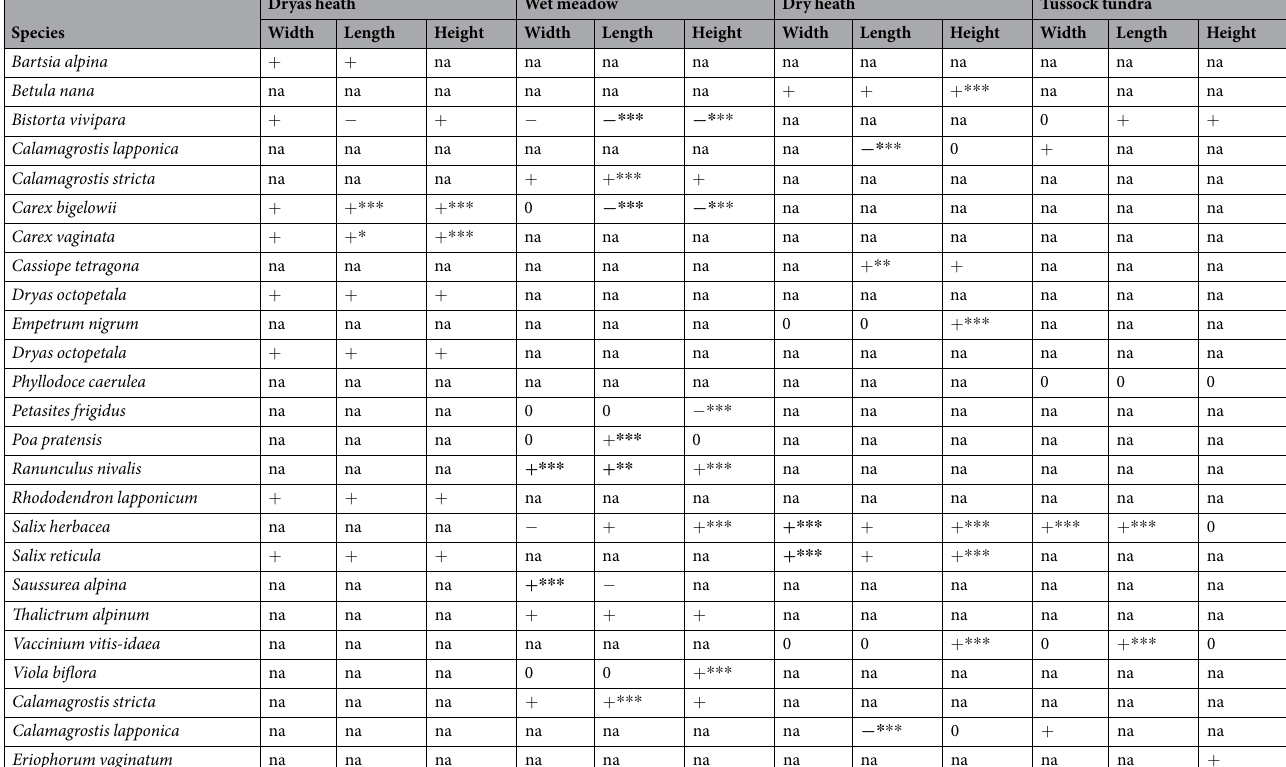
Table 1. Responses in plant species traits (leaf width, leaf length and plant height) to 23 years of warming in the Dryas heath, wet meadow, dry heath and tussock tundra plant communities at Latnjajaure, subarctic Sweden: positive response ( + ), negative response ( − ) and no response (0). Significance lev e ls: *** p < 0.0001; ** p < 0.001; * p < 0.01; na: data not